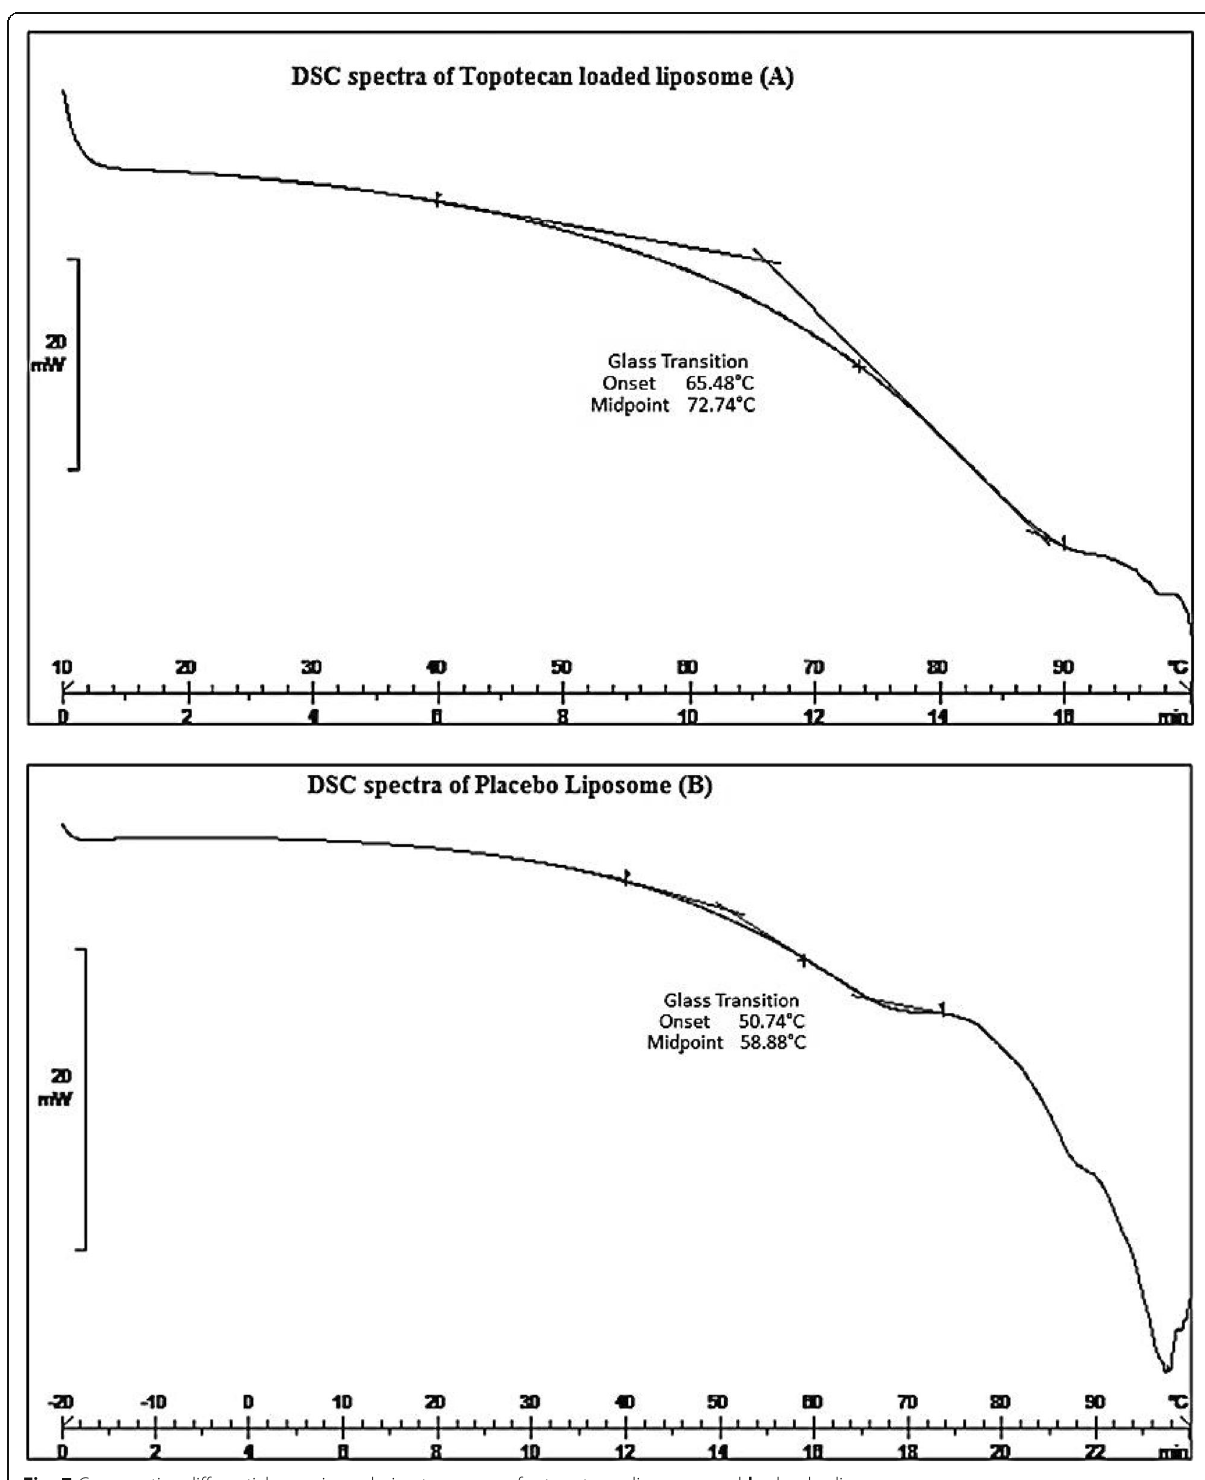
Fig. 7 Comparative differential scanning calorimetery curve of a topotecan liposome and b placebo